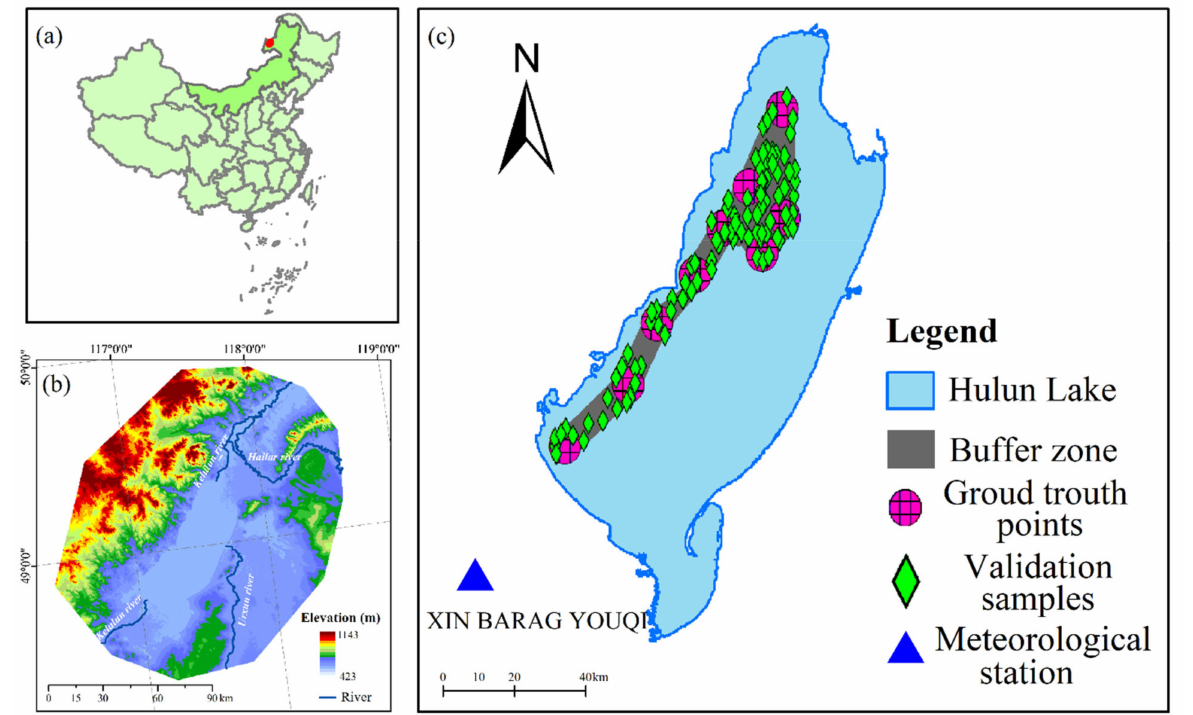
Figure 2. The location of the study area. ( a ) the geographical location of the study area; ( b ) the elevation of the study area; ( c ) the distribution of meteorological stations and field